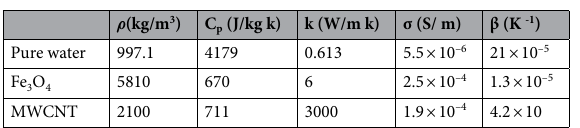
Table 1. Thermo physical properties of water and nanoparticles 50